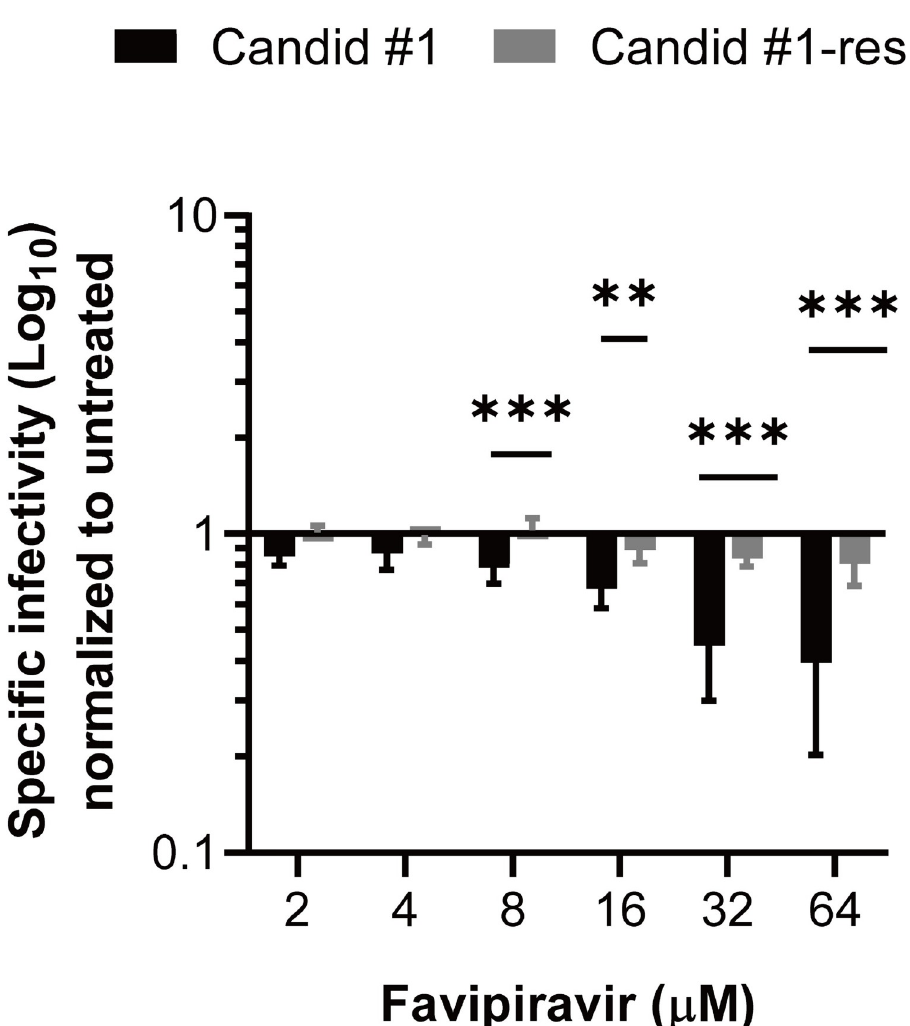
Fig 5. Specific infectivity of Candid #1 and Candid #1-res viruses. 293T cells were infected with each virus (MOI: 0.01) and treated with different concentrations of favipiravir or DMSO. S pecific infectivity values at 48 hpi, were calculated using the ratio of infectious particles (Log 10 PFU/mL) to the RNA copy numbers (Log 10 copies/mL). Values were normalized to DMSO-treated controls. Error bars indicate ± SD; two independent experiments in four biological (n = 8) were performed. Statistical significance was determined by 2-way ANOVA test ( �� indicates P < 0.01 and ��� indicates P < 0.001). This suggests that increasing concentrations of favipiravir caused the accumulation of lethal mutations that lead to the loss of JUNV infectivity [36, 42]. In contrast, specific infectivity of Candid #1-res virus was only slightly affected from 1.009 to 0.80 log PFU per mL/log RNA 10 10 copies per mL, when exposed to 2- μ M and 64- μ M favipiravir, respectively. The significant reduction in specific infectivity of Candid #1 compared to that of the Candid #1-res virus ( P < 0.0001, two-way ANOVA test) suggests that the resistant mutant is less susceptible to the mutagenic effect of favipiravir. Notably, we did not observe any difference in viral RNA copy numbers between Candid #1 and Candid #1-res variants across any concentration (up to 64 μ M) of favipiravir treatment, further indicating the presence of genomic RNA that are not capable of producing infectious virus. A reduction in specific infectivity is the hallmark of